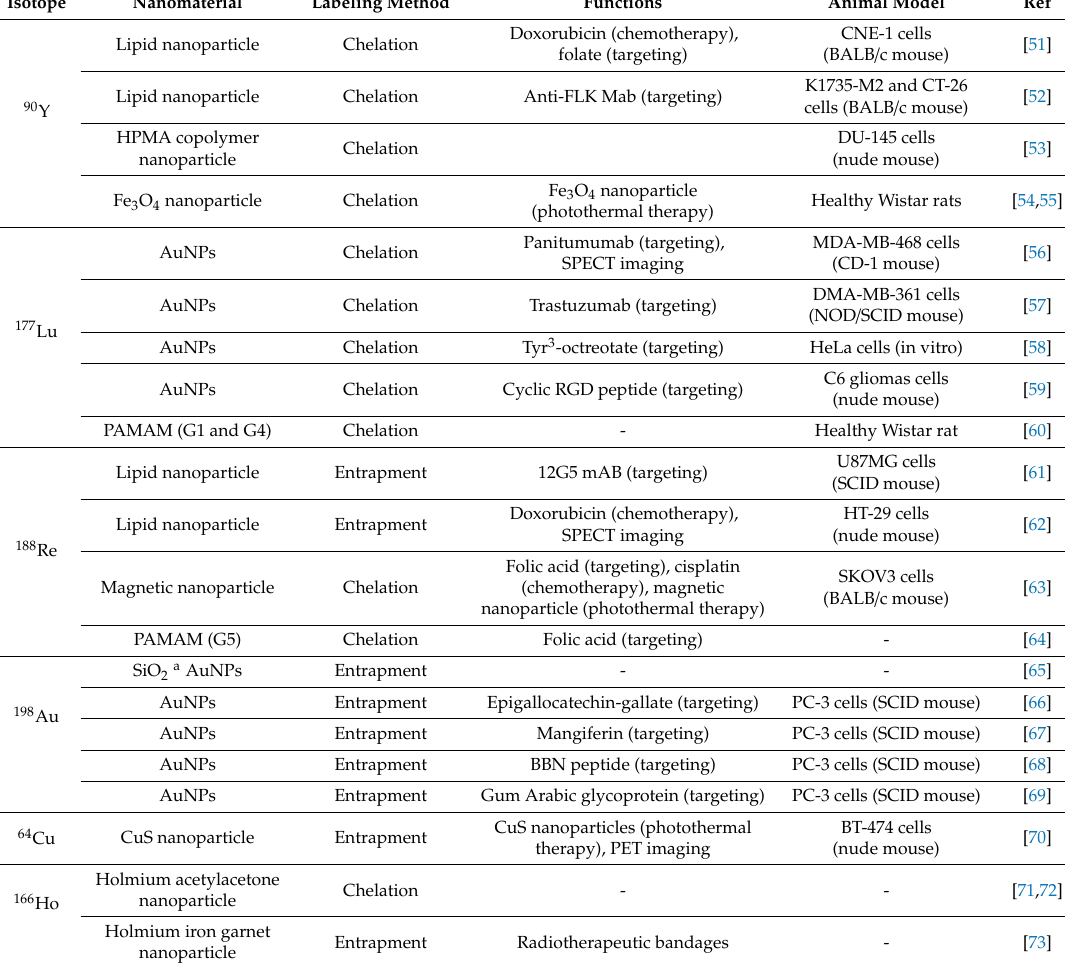
Table 3. β -ray-emitting radiometal-labeled functional